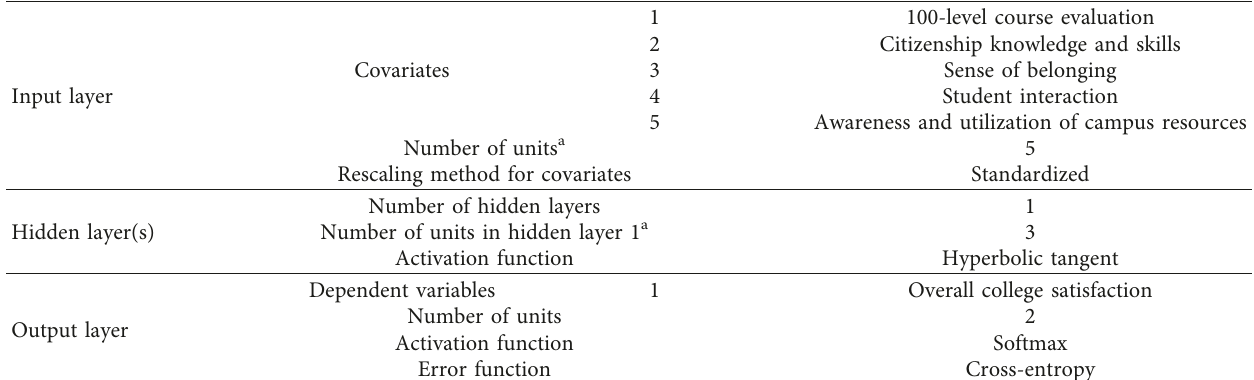
Table 13: Network information.